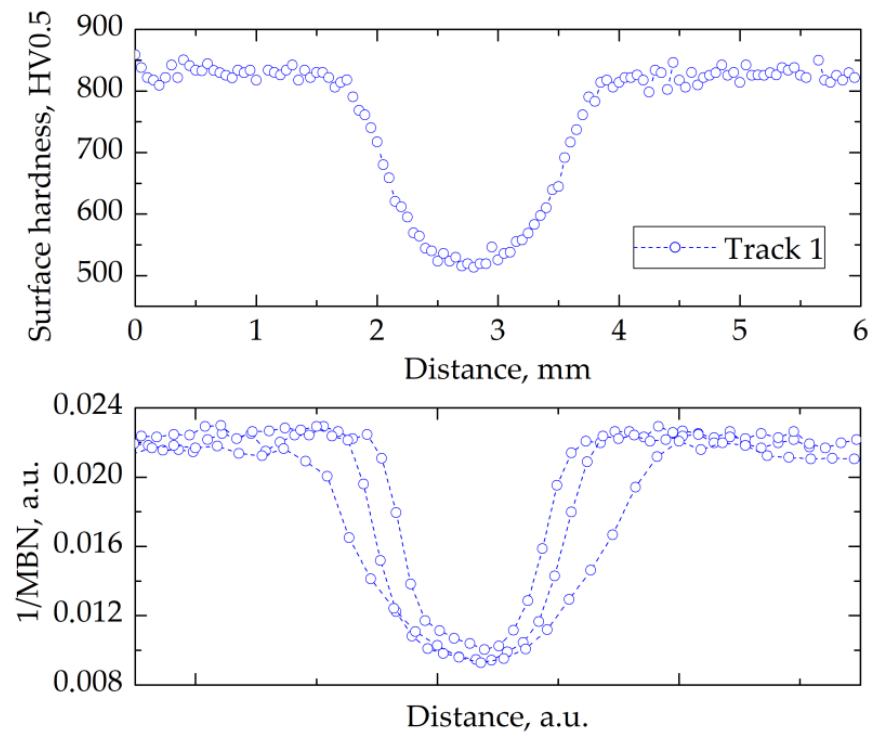
Figure 10. Relation between hardness (upper panel) and normalized 1/MBN (lower panel) as a function of distance (surface coordinate) across the laser-processed track 1.